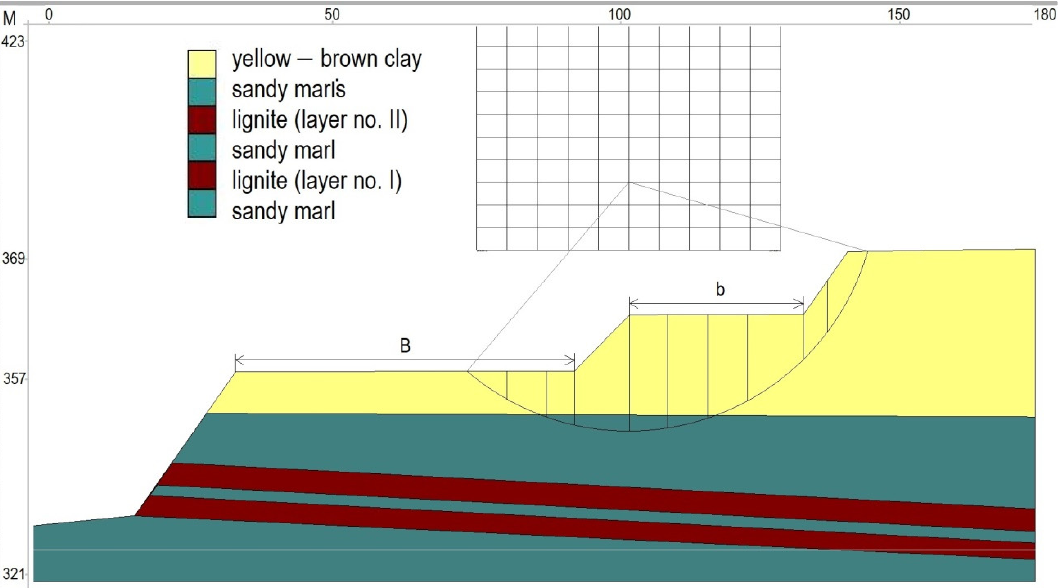
Figure 13. Section P1—Stability analysis of the sub-steps system (excavated in yellow-brown clay).